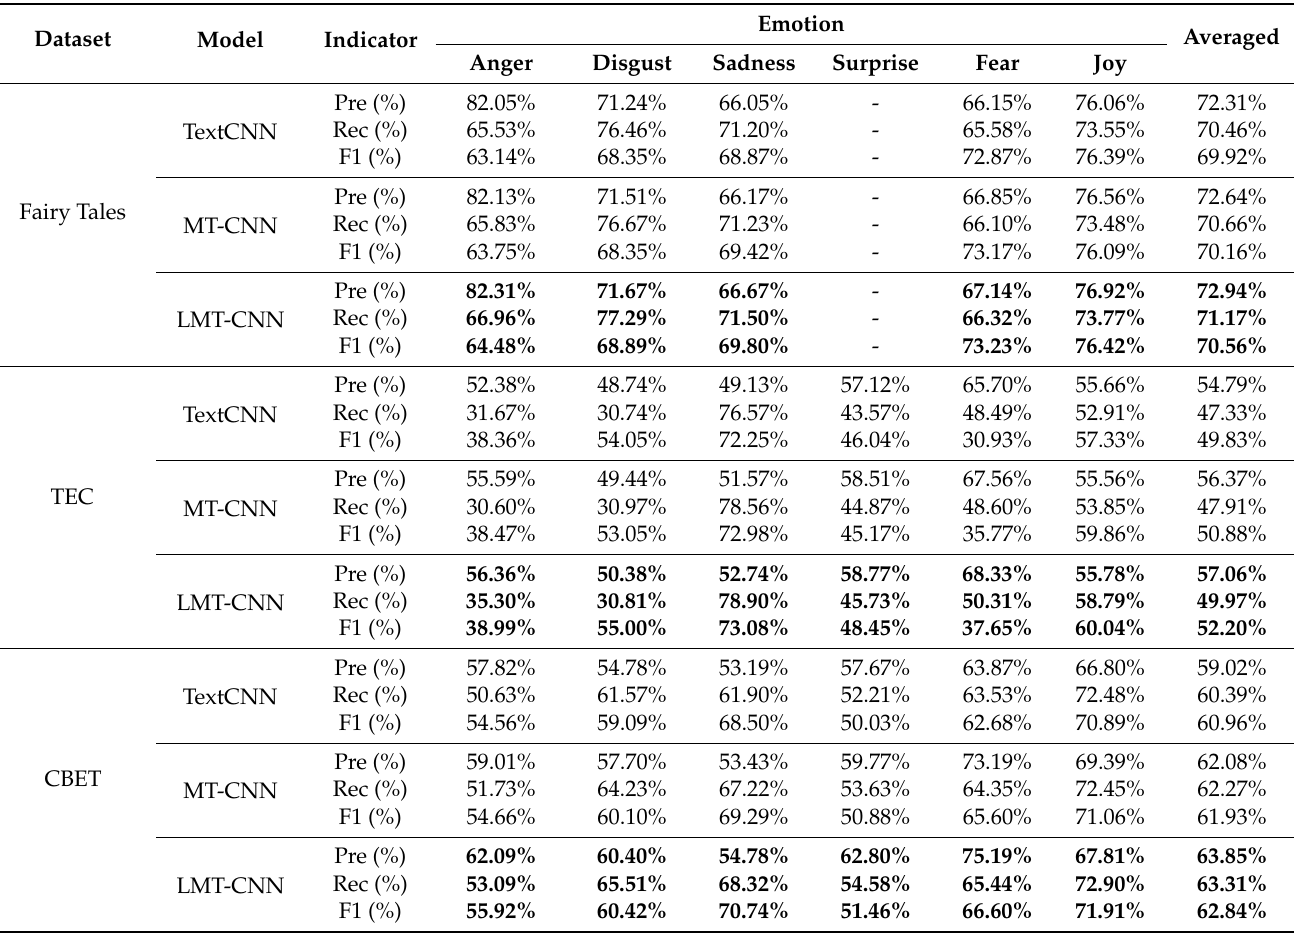
Table 6. Comparative performance of three CNN-based EDL models for emotion classification. The best performances of each indicator on each dataset are marked in